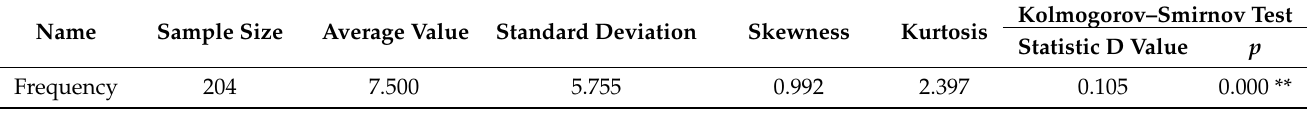
Table 7. Normality test of key-style